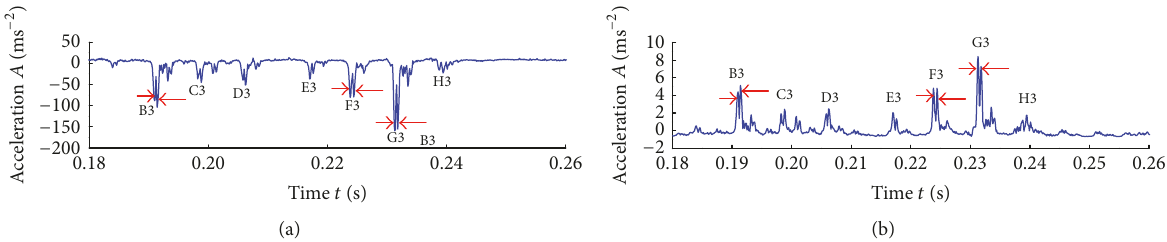
Figure 19: Enlarged view of intrinsic envelope from 0.18 to 0.26 sec: (a) corresponding to Figure 18(a); (b) corresponding to Figure 18(b).